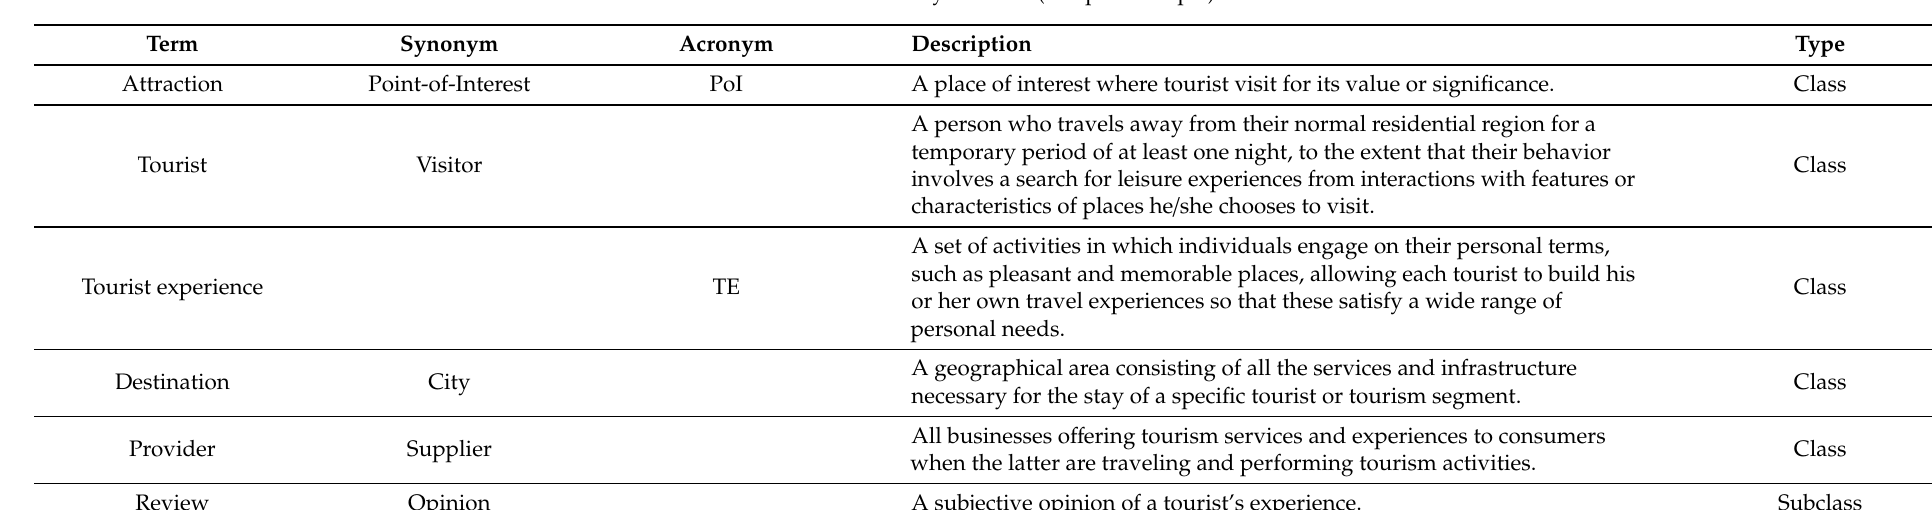
Table 3. Glossary of a TTS (sample